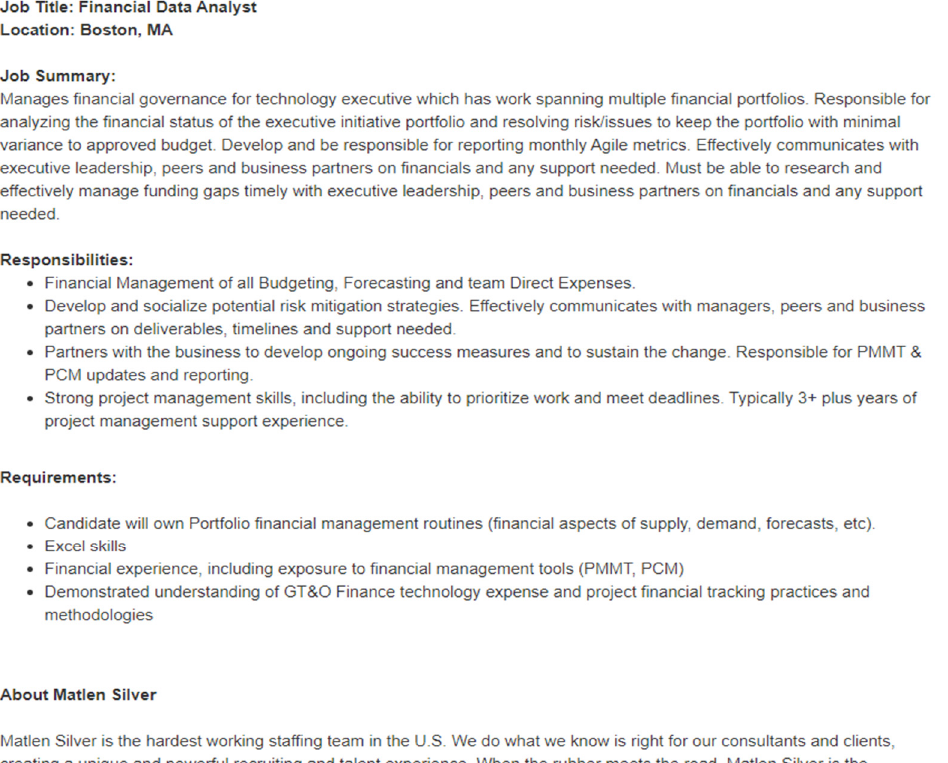
Example of a job advertisement on the job portal www.dice.com (accessed on 31 August